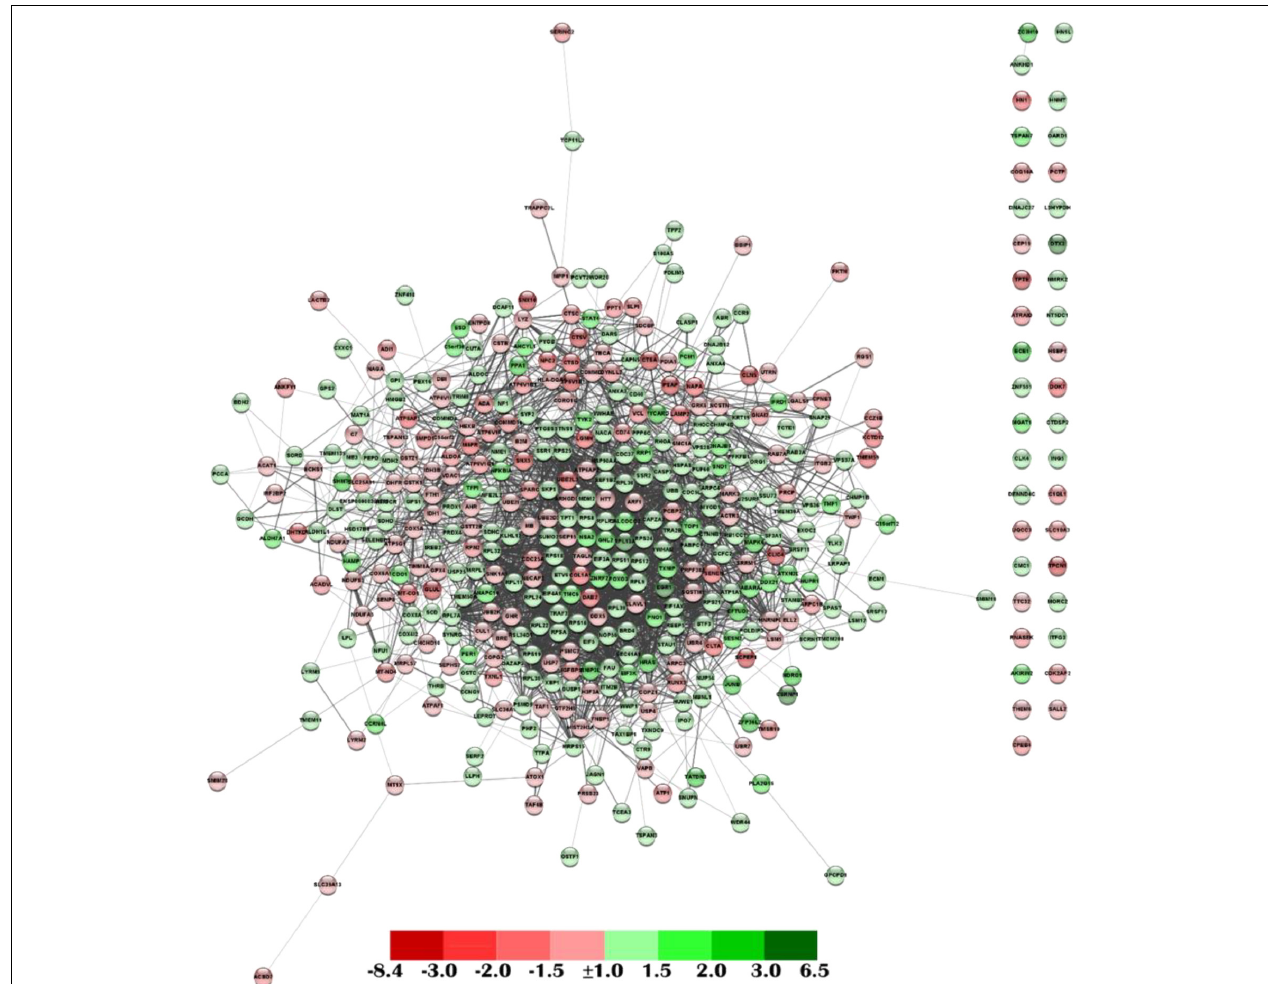
FIGURE 2 | Functional network analysis from the anterior intestine of the gilthead sea bream fed the SDPP diet. Each node represents one differential expressed gene (DEG) obtained from the anterior intestine transcriptomic analysis. The DEG modulatory profile is represented with green (up-regulated) and red (down-regulated) into each node according to its fold-change magnitude interval. The green (up-regulation) and red (down-regulation) color scheme indicates the gene modulation according to its magnitude interval